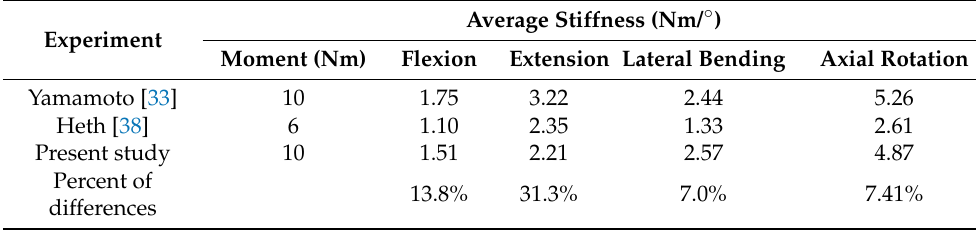
Table 3. Comparison of average stiffness between the models in the study.